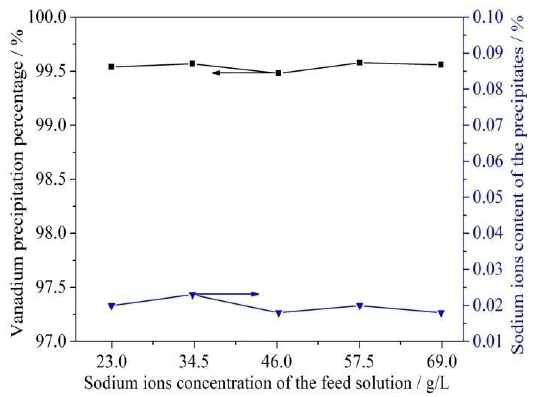
Figure 3. The effect of sodium ions concentration of the feed solution on the vanadium precipitation percentage and the sodium ions content of the precipitates.